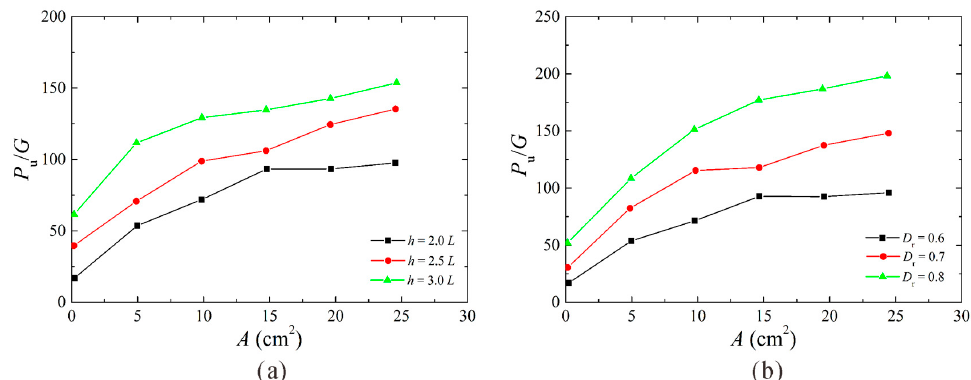
Figure 10. P – A curves of the TAs under vertical pullout loading ( a ) D r = 0.6; ( b ) h = 2.0 L.